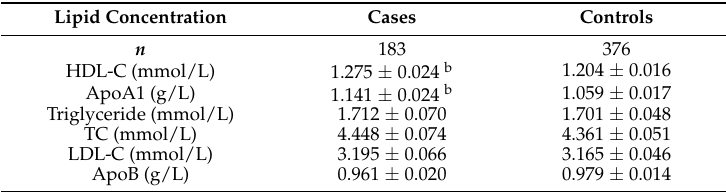
Table 4. Maternal lipid levels in spontaneous preterm delivery cases and term controls a . Lipid Concentration Cases Controls